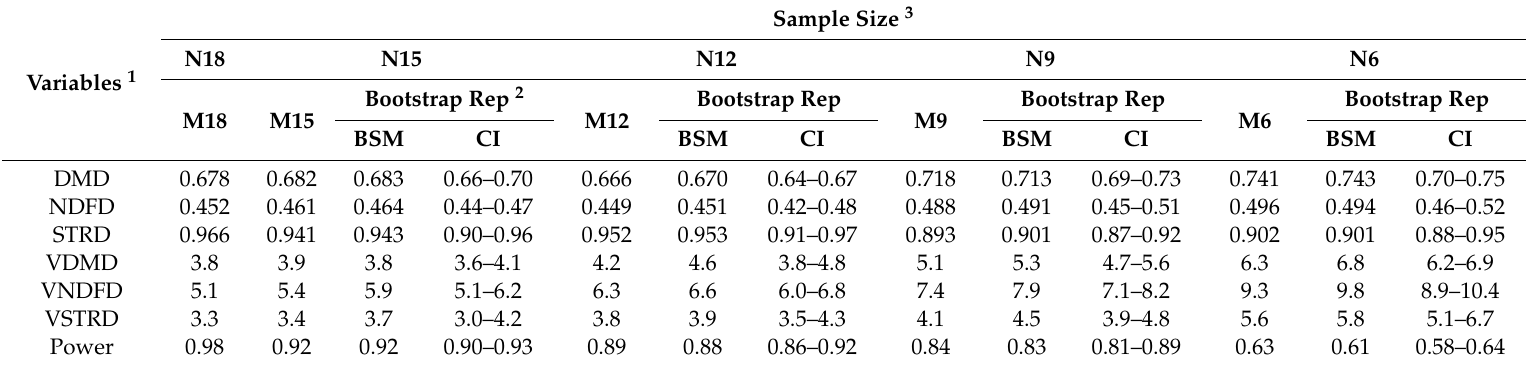
Table 2. Descriptive statistics and statistical power estimates of original five sample sizes and bootstrap